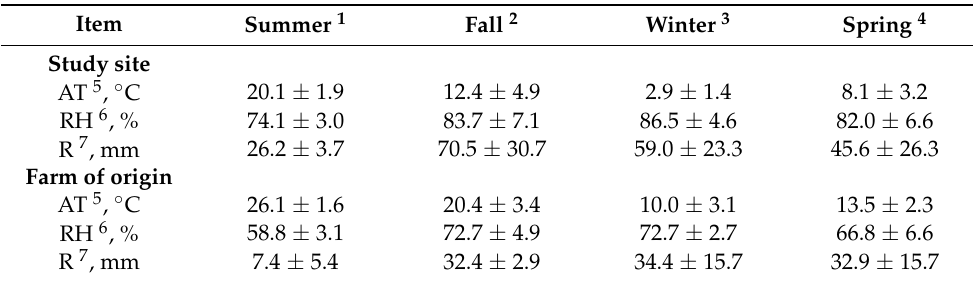
Table 3. Seasonal climatic data (mean ± standard deviation) of the experimental farm and origin farm during the experimental